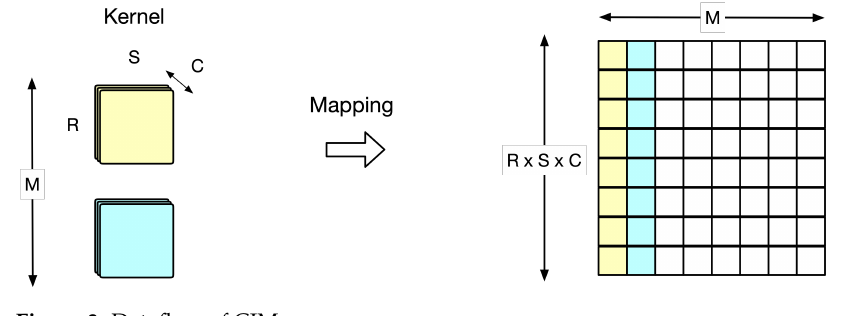
Figure 3. Dataflow of CIM.